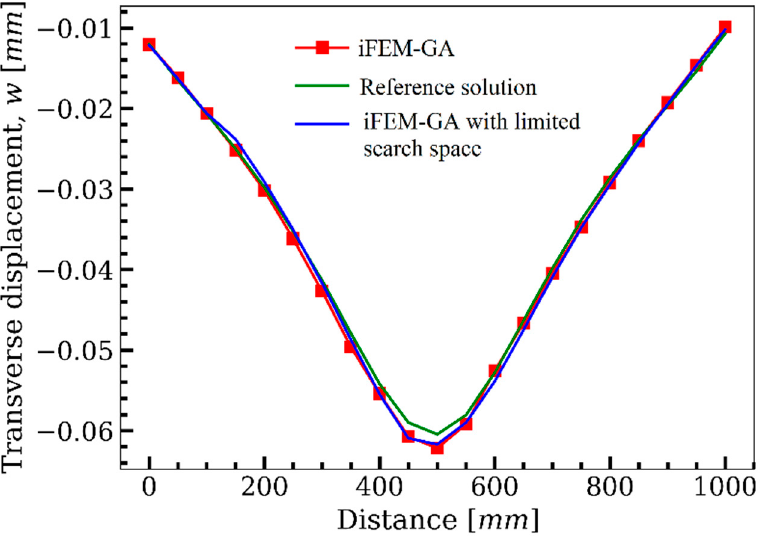
Figure 18. The comparison of the deflection of the plate in Figure 15 obtained with iFEM-GA analysis, iFEM-GA analysis with limited search space, and the reference solution through a defined path.